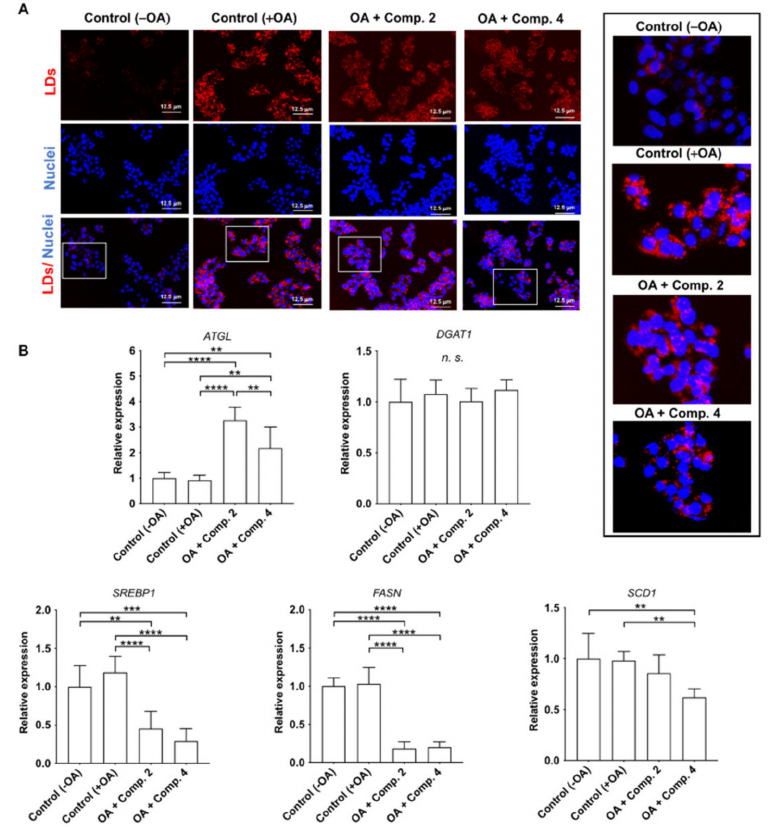
Figure 6. ( A ) LDAI activity of compounds 2 and 4 in HepG2 cells: fluorescence images showing LDs (red) and nuclei (blue); ( B ) Gene expression. All data were normalized to the expression of glyceraldehyde-3-phosphate dehydrogenase ( GAPDH ) and were represented as the relative expres- sion based on that for the control group. ATGL : adipose triglyceride lipase; DGAT1 : diacylglycerol O-acyltransferase 1; SREBP1 : sterol regulatory element-binding protein 1; FASN : fatty acid synthase; SCD1 : stearoyl-CoA desaturase 1. ** p < 0.01, *** p < 0.001, **** p < 0.0001 ( n = 6 in each